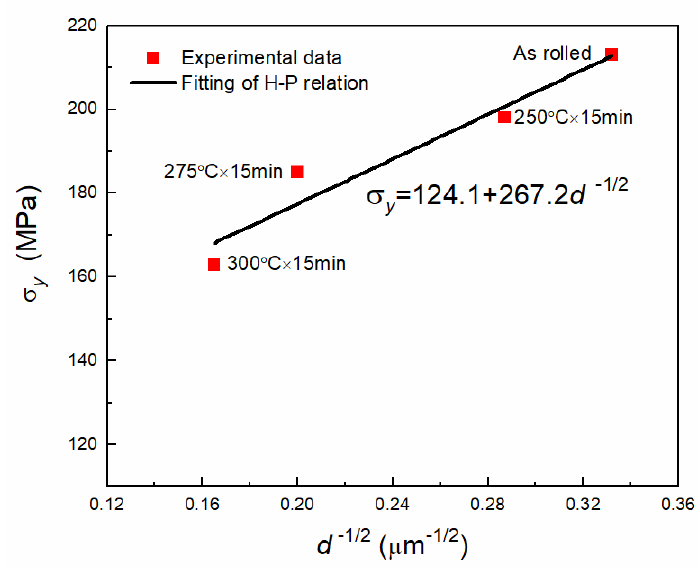
Figure 9. Hall–Petch relationship for the Mg-6Al plates in as-rolled and post-heat-treated condi-